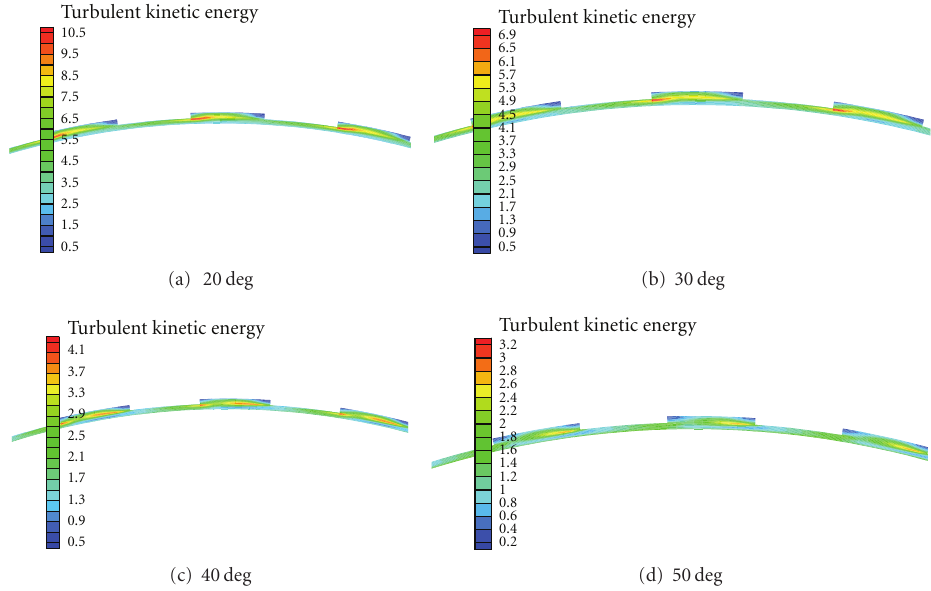
Figure 11: Contours of turbulent kinetic energy of 0.2 L cross section for four helix